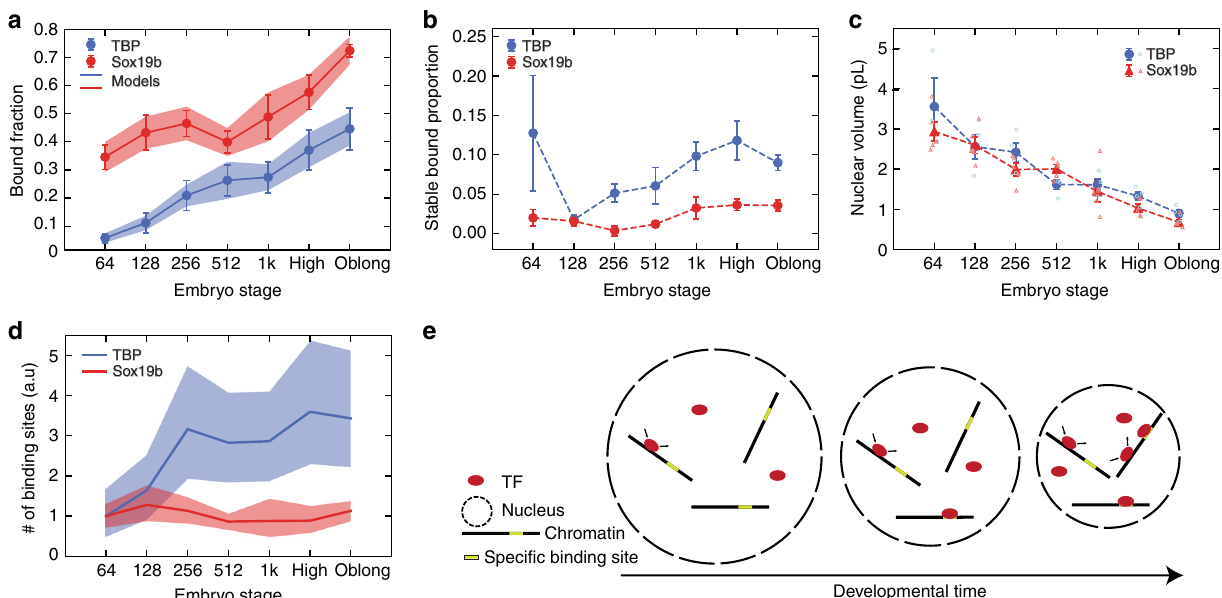
Fig. 5 The chromatin-bound fractions of mEos2-TFs increase during early development. a Chromatin-bound fraction of mEos2-TBP (blue) and mEos2- Sox19b (red) during development (calculated from data presented in Fig. 4 and Supplementary Figure 11, mean ± s.e.m). Lines represent the chromatin- bound fraction as calculated from the law of mass action using data from b and c and extracting the apparent number of chromatin binding sites as free parameter. Shades represent error intervals propagated from the errors in stable bound proportion and nuclear volume. The panel includes in total 120572 molecules from 5 embryos (64-cell stage) and 6 embryos (later stages) for mEos2-TBP and 158912 molecules from 5 embryos for mEos2-Sox19b. b Stable bound proportion of chromatin-bound mEos2-TBP (blue) and mEos2-Sox19b (red) molecules during development (calculated from data presented in Fig. 4 and Supplementary Figure 11, mean ± s.e.m.). The panel includes in total 5677 molecules from 3 embryos (64-cell stage), 4 embryos (128-cell stage), 5 embryos (256-cell stage) and 6 embryos (later stages) for mEos2-TBP and 13103 molecules from 5 embryos for mEos2-Sox19b. The dashed line is given as guide to the eye. c Nuclear volume of mEos2-TBP (blue spheres) and mEos2-Sox19b (red triangles) injected embryos during development. Data includes 5, 16, 22, 25, 32, 37, 84 measurements from 3 embryos (64-cell stage) and 4 embryos (later stages) for mEos2-TBP and 17, 21, 33, 60, 42, 90, 98 measurements from 5 embryos for mEos2-Sox19b (mean ± s.e.m. mean values for single embryos shown as open circles for TBP and open triangles for Sox19b). The dashed line is given as guide to the eye. d Apparent number of chromatin binding sites of mEos2-TBP (blue) and mEos2-Sox19b (red) as calculated from the law of mass action using data from a , b , and c . Shades represent error intervals propagated from the errors in chromatin-bound fraction, stable bound proportion and nuclear volume. e Scheme of the concentration model. During early embryo development the size of individual nuclei decreases, thereby increasing the concentration of DNA and increasing the chromatin-bound fraction of